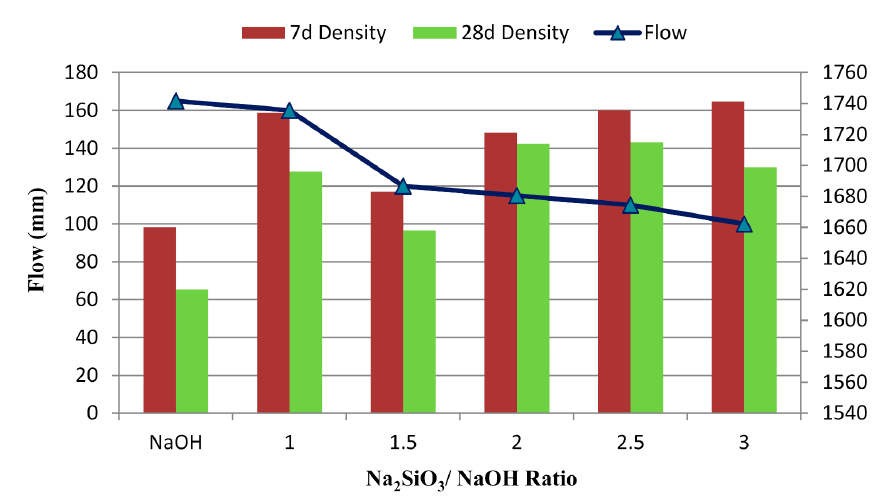
Figure 7. Flow of alkali-activated POFA paste at different Na 2 SiO 3 /NaOH ratios. The initial and final setting times were indicated for the mixture for the single and binary alkaline activators. Based on a study by Salih et al. [11], the initial and final setting times for Portland cement were 50 and 195 min, respectively. Figure 8 shows the setting times for the alkali-activated POFA geopolymer at different alkaline activator ratios. It also shows that the mixtures required considerable time to set. The use of POFA as the main material prolonged the setting reaction. Our results show a decline in the setting time as the Na 2 SiO 3 content increased. The mixture with a 3.0 ratio of Na 2 SiO 3 /NaOH required the shortest setting time (Figure 8). According to ASTM C150 [52], the initial minimum setting time was 45 min, and the maximum setting time was 365 min. For all mixtures,